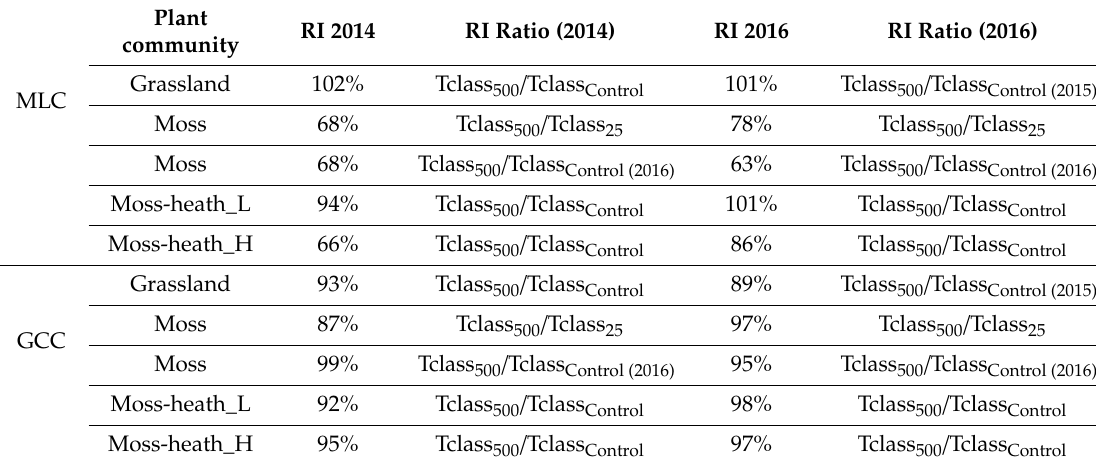
Table 3. Resistance Index (RI) calculated for the years 2014 and 2016, for both Maximum Likelihood Classification (MLC) and Green Chromatic Coordinate (GCC). RI is comparing the ratio between treatment class 500 and the control lane, or other comparison (see RI Ratio explanation) for the di ff erent plant communities: Grassland, Moss, Lowland Moss-heath (Moss-heath_L), and Highland Moss-heath (Moss-heath_H). Tclass = Treatment class, followed by a number (e.g., 500 = treatment class 500) or Control (0 passes). If followed by a year in parenthesis the Control was from a di ff erent